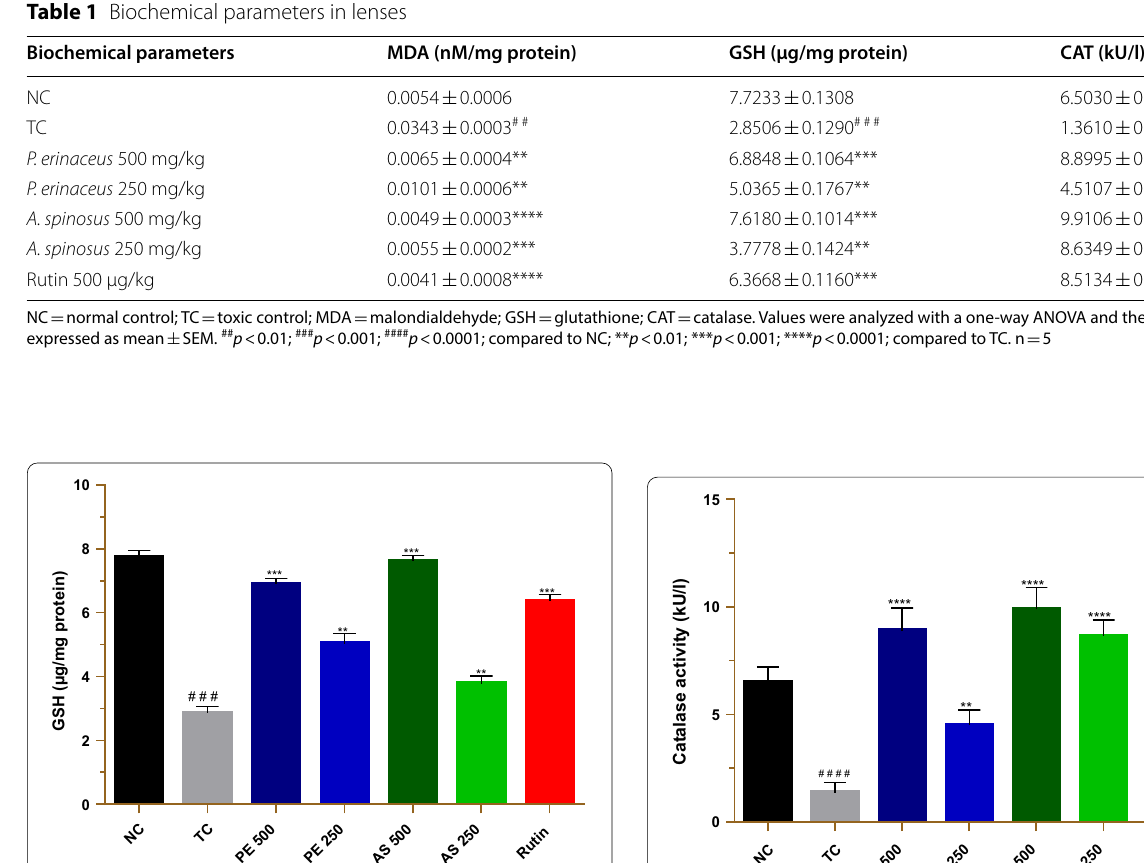
Table 1 Biochemical parameters in lenses Biochemical parameters